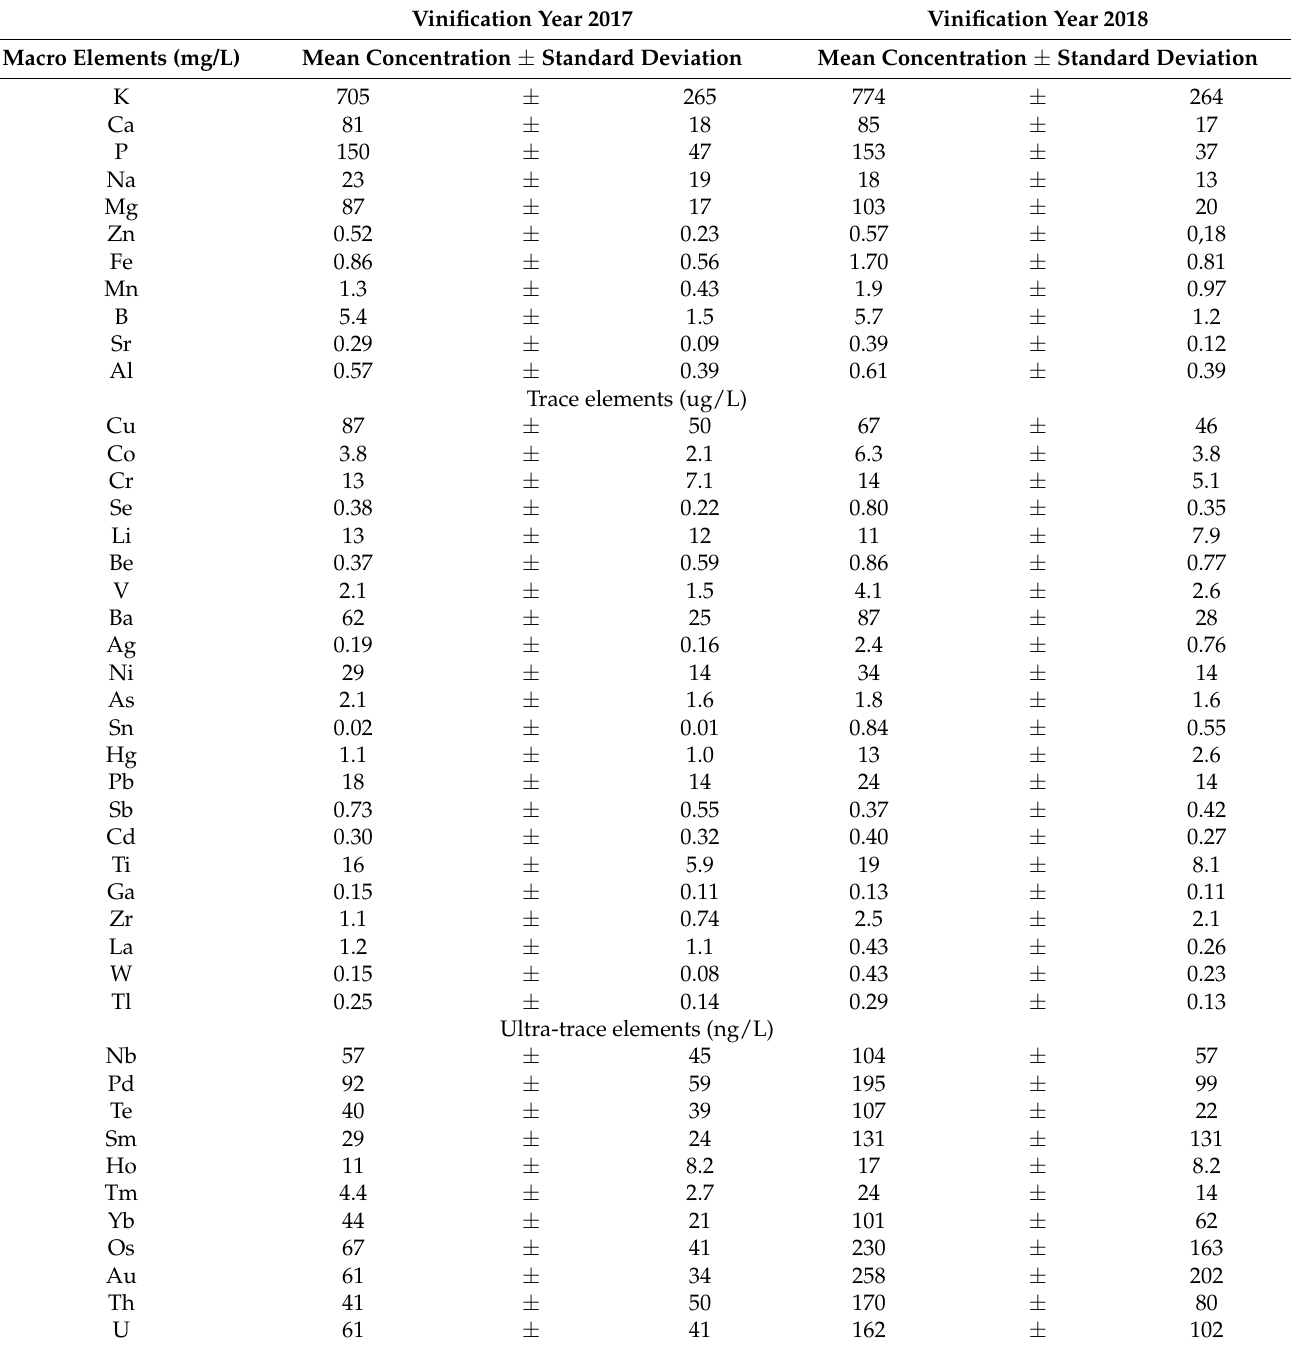
Table 2. An overview of metal content (mean ± standard deviation) of Greek wine samples for the two consecutive vinifications, 2017 and